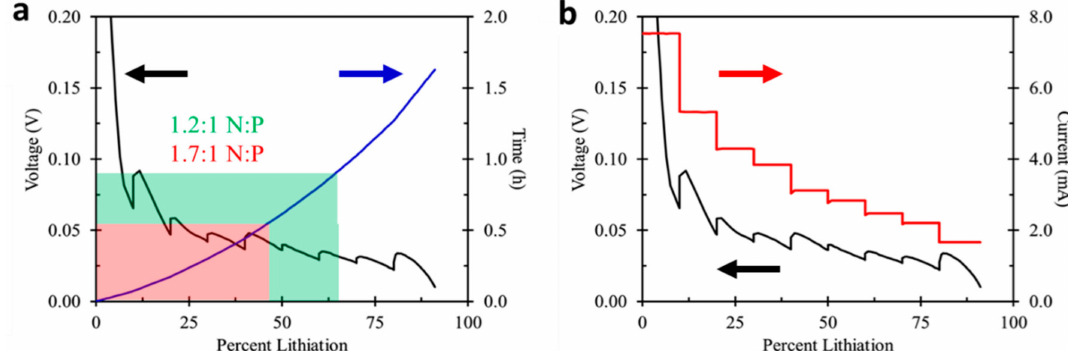
Figure 3. ( a ) Corresponding lithiation time (blue) to 80% SOC, or 67% and 47% graphite utilization for cells with either a 1.2:1 (green) or 1.7:1 (red) negative to positive reversible capacity ratio and ( b ) accelerated graphite electrode lithiation procedure, showing current (red) and associated half-cell voltage profile